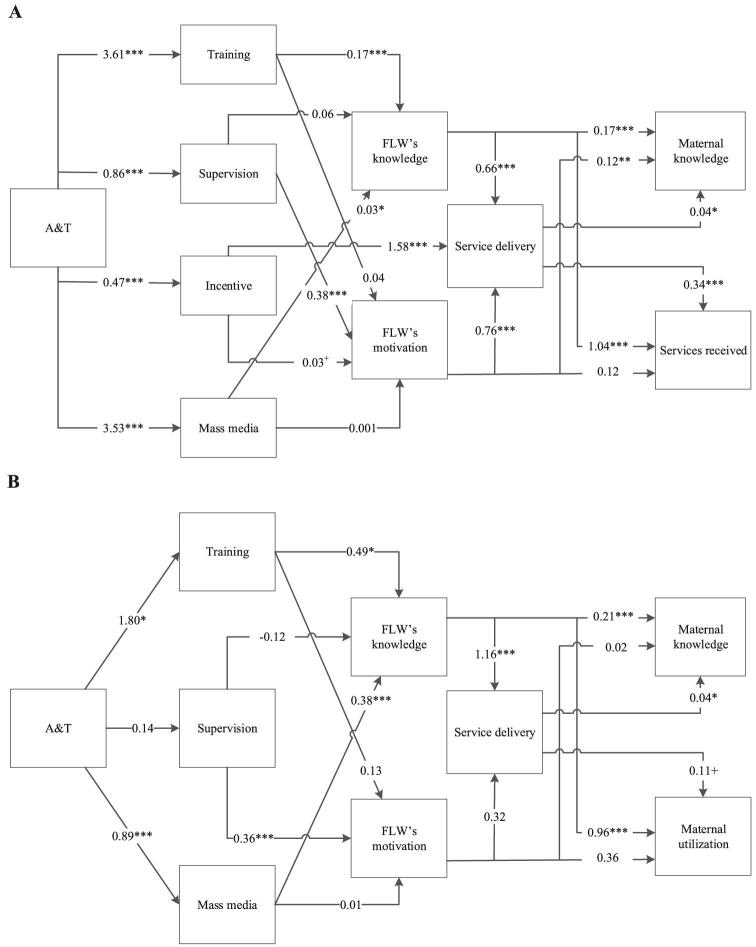
Paths from exposure to performance outcomes measured at the FLW and end-user levels. Bangladesh SS (A) and Vietnam HS (B). Values are coefficients. +, *, **, ***Significant difference between intensive and non-intensive areas, accounting for geographic clustering: +P < 0.10, *P < 0.05, **P < 0.01, ***P < 0.001. A&T, Alive & Thrive; FLW, frontline worker; HS, health staff; SS, Shasthya Sebika.